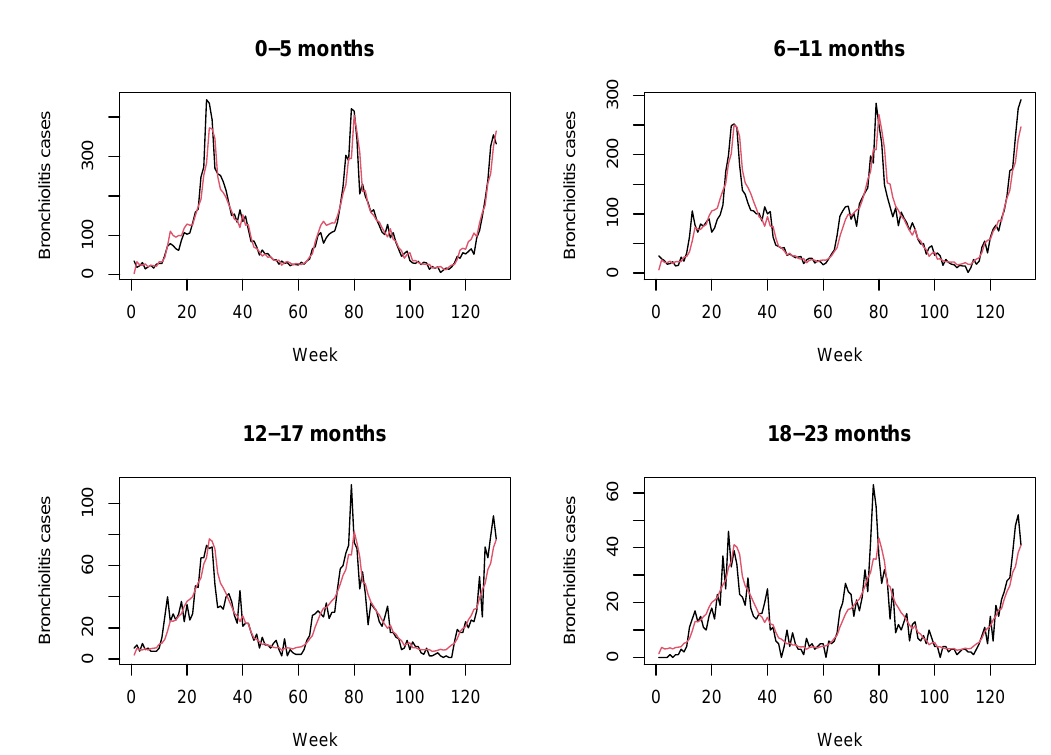
Figure 4. Bronchiolitis counts (black line) together with posterior mean estimates (red line) obtained with a Poisson model with two